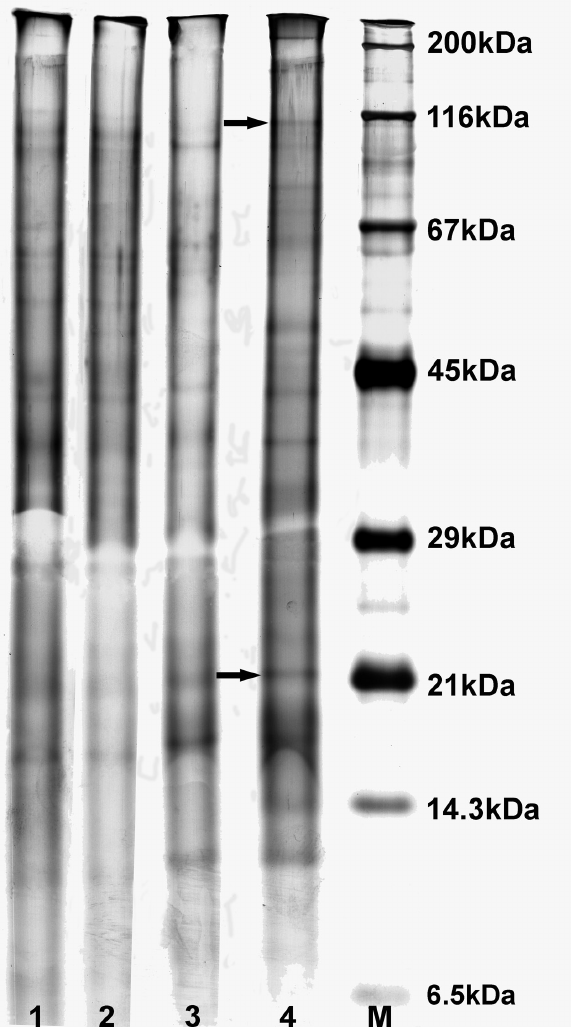
Fig . 5. – SDS PAGE of nematocyst extracts of fishing tentacles (FT) and mesenteric tentacles (MT) from Cyanea capillata. Ccap14, pooled sample of 9 medusae with an average umbrella diameter of 14.2 cm; Ccap55, one medusa with an umbrella diameter of 55 cm; M, marker for the estimation of molecular weights between 6.5 and 200 kDa; 1 Ccap14 MT; 2 Ccap14 FT; 3 Ccap55 MT; 4 Ccap55